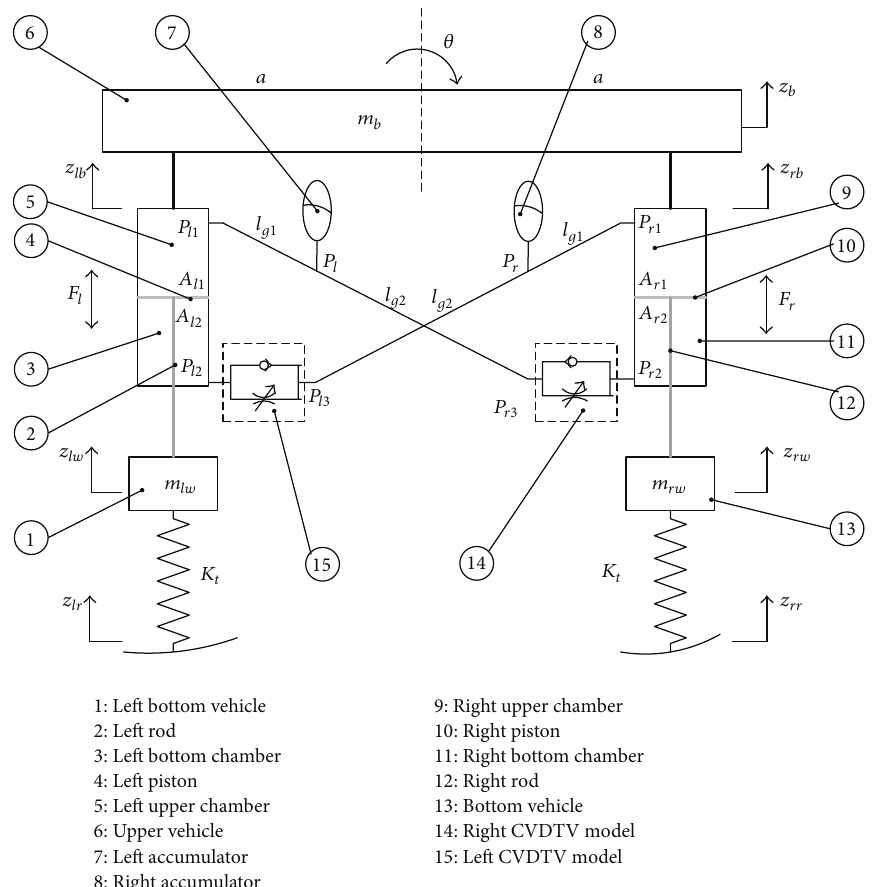
Figure 1: Semiactive connected hydropneumatic